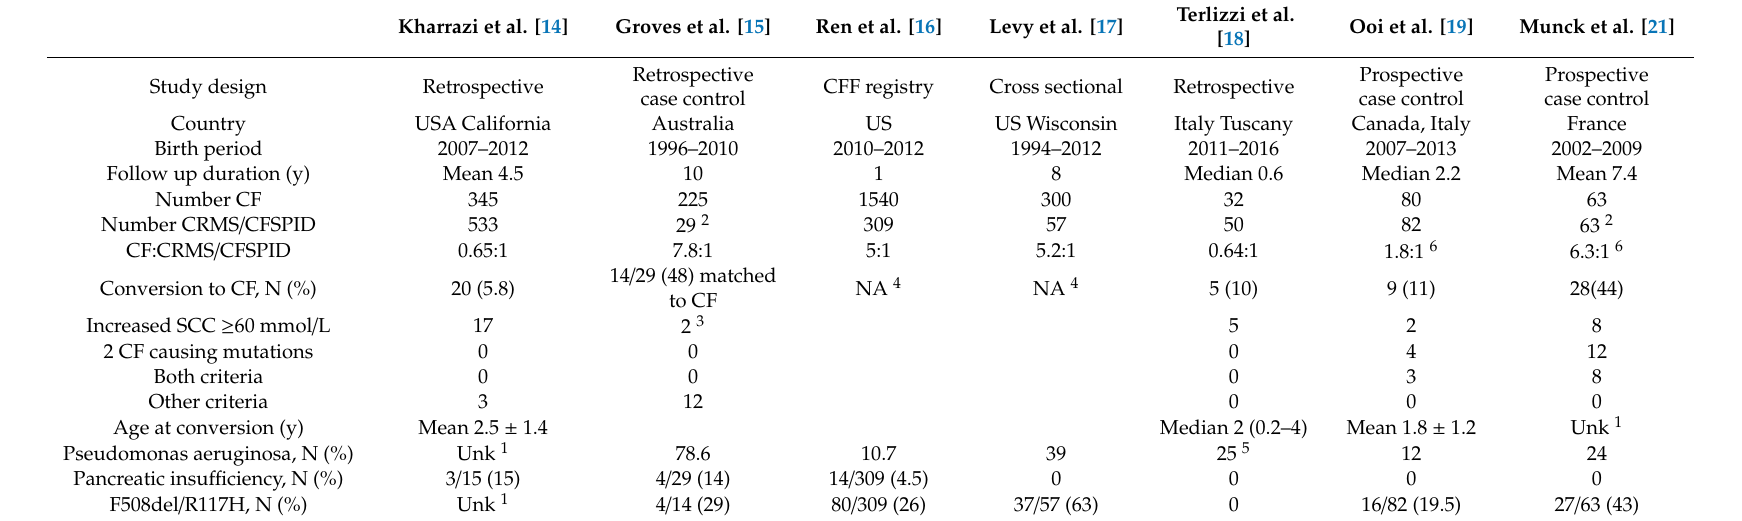
Table 2. Summary of recent studies of CRMS /